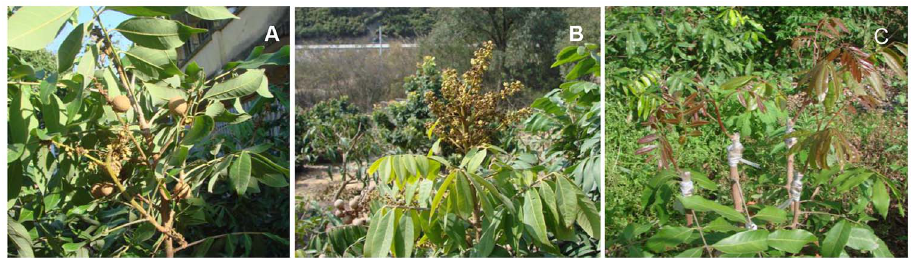
Figure 1. Sepecific flowering traits in ‘Sijimi’ longan. A . ‘Sijimi’ longan blossoming continuously, both terminal and axillary shoots can differentiate into inflorescences, flowers and fruits can be observed on one tree at the same time. B. When the growth is inhibited, apical buds develop into pure inflorescences. C . Scions of ‘Sijimi’ and ‘Lidongben’ were grafted on different branches of one rootstock plant.